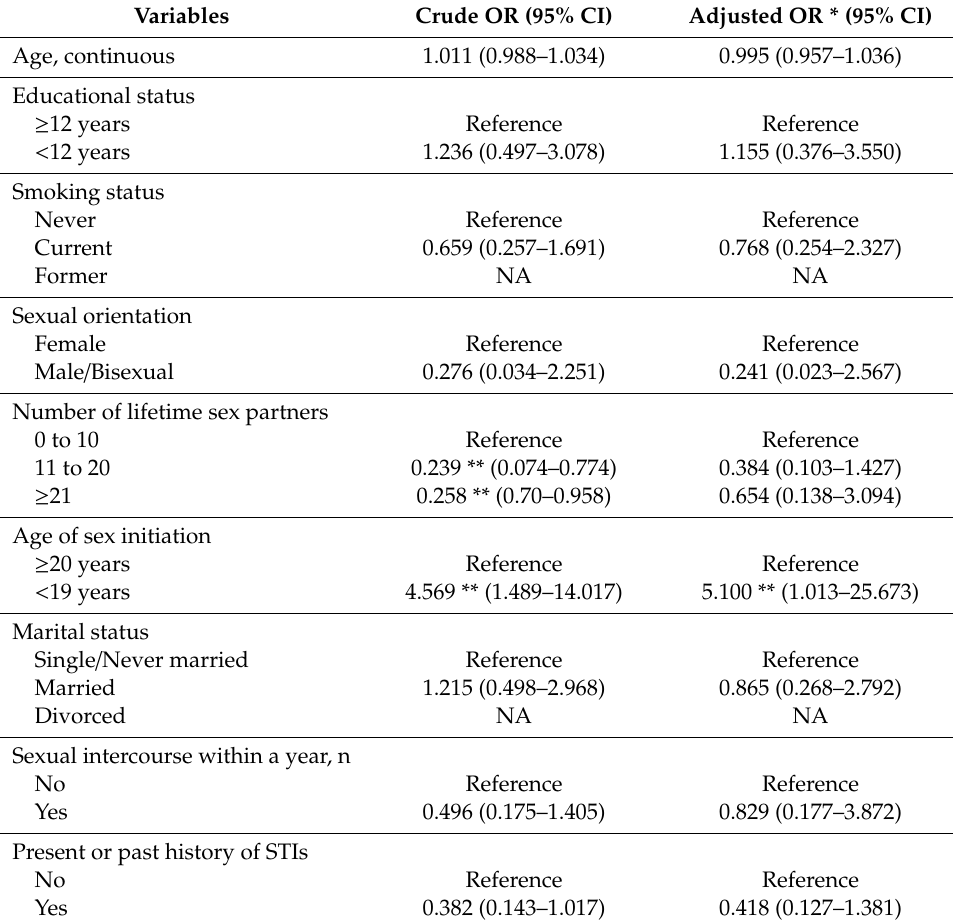
Table 4. Predictors against HPV infection targeted by the 2v HPV vaccine.